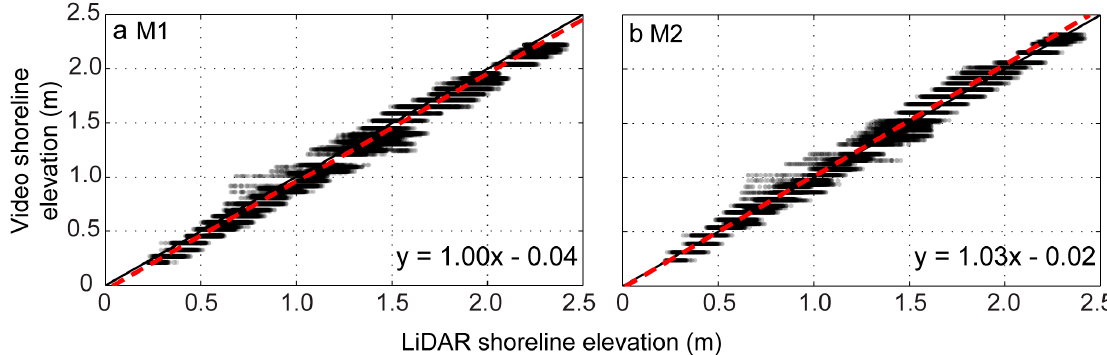
Figure 7. Video-based shoreline elevations versus LiDAR data as parameterized with the shoreline elevation model including only the mean water level (M1) ( a ) and the total water level (M2) ( b ). Regression lines are shown by red dashed lines. The black line represents the 1:1 line. Differences lay mostly on the offset values, with an origin offset of − 0.04 for the M1 (mean water level only) and − 0.02 m for M2 (total water level), respectively. These results indicate that the overall contribution from H s is small in the total water level approximation (M2) but it reduces the origin offset by 2 cm. Slopes of both regression lines are very near 1:1, with the coefficient of the M2 being slightly higher than the M1 (1.03 instead of 1.00). Although the highest wave reached only 0.14 m, this difference can be mainly explained by higher waves at high tide in the M2 model, which is not considered in the mean water level model (M1). Almar et al. [38] noted similar results, indicating a